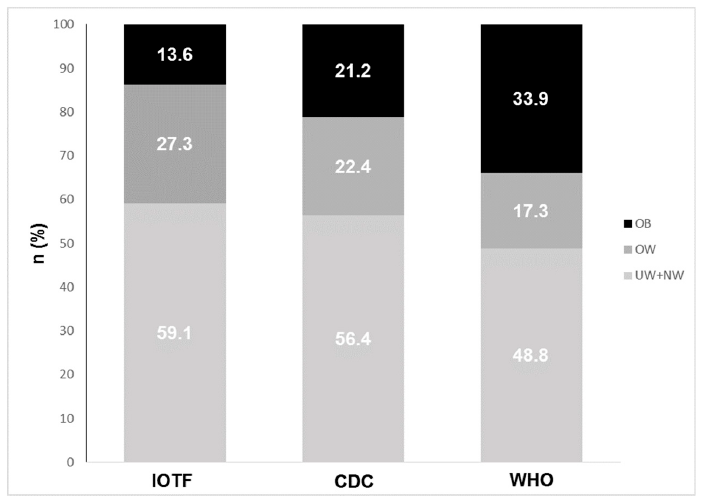
Figure 1. Prevalence of normal weight “NW”, over weight “OW”, and obese “OB” children categorised by three different BMI references: IOTF, CDC, and WHO.